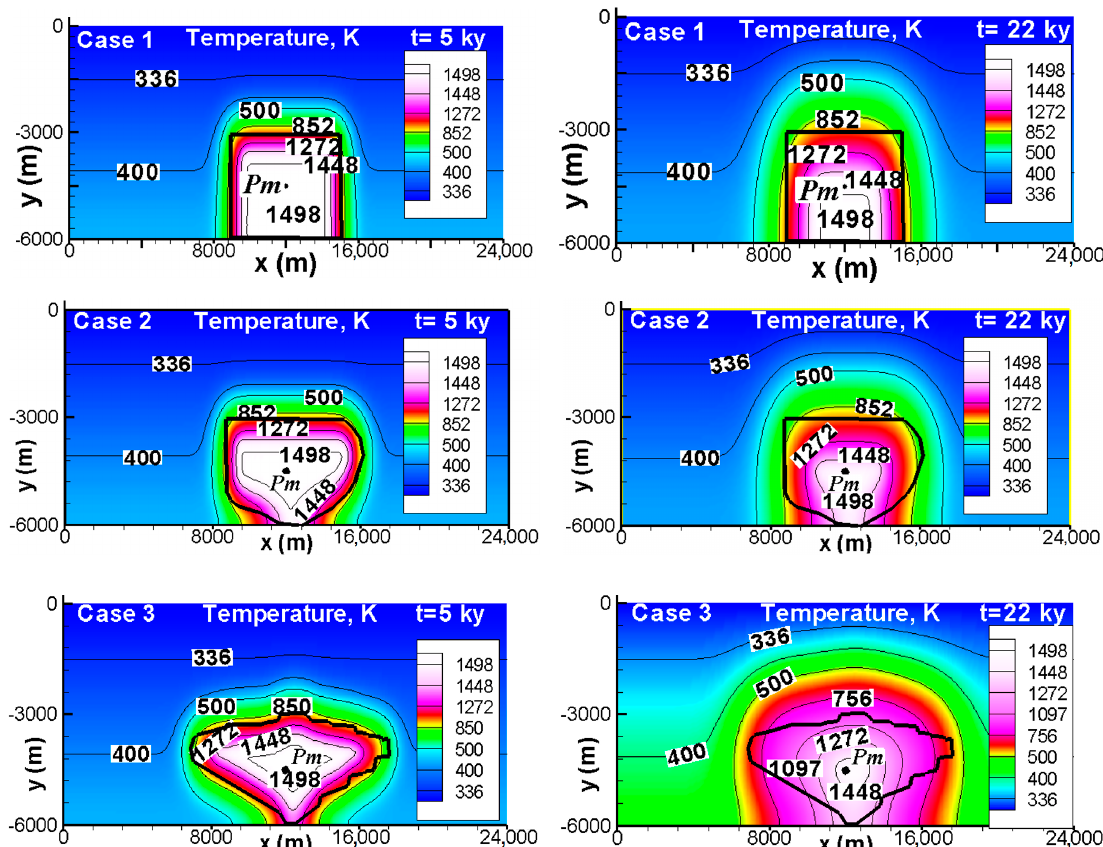
Figure 4. Temperature distributions at two different times inside the chamber and host rock for 1498 K and 1223 K correspond to magma (liquid and crystal mixture). Zones with temperatures lower than 1223 K are considered to be solid.